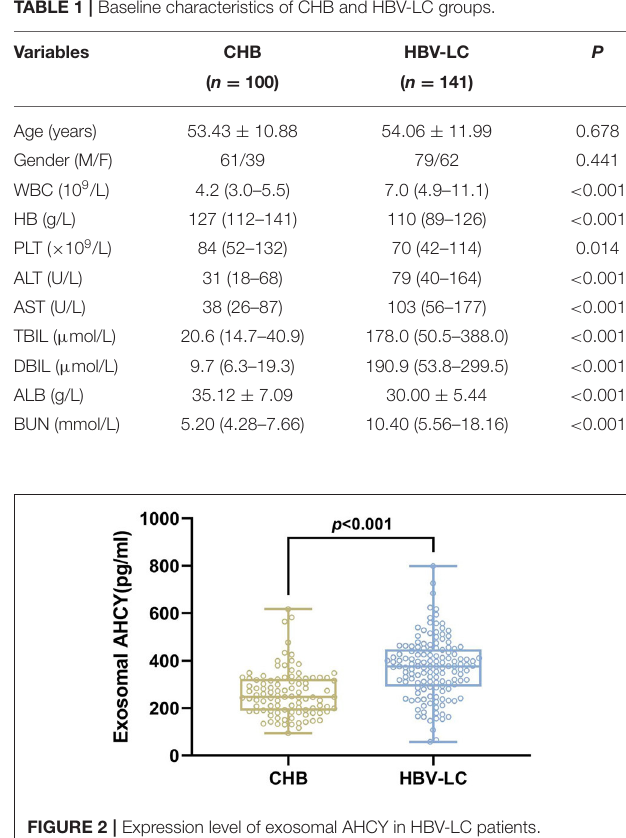
FIGURE 2 | Expression level of exosomal AHCY in HBV-LC patients.